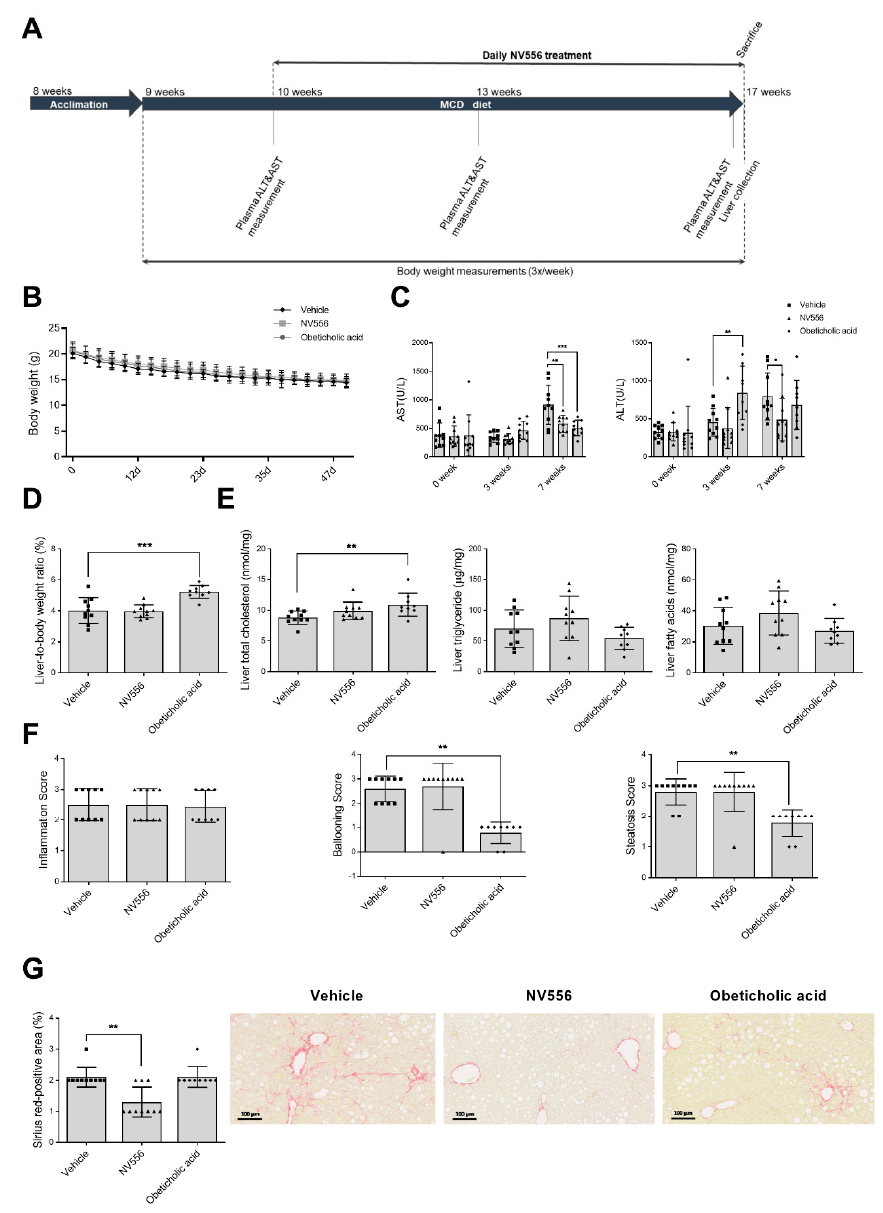
Figure 1. Effect of NV556 treatment in methionine-choline-deficient (MCD)-diet-fed mice. ( A ) Experimental timeline and parameters measured: ( B ) body weight, ( C ) AST, and ALT, ( D ) liver/body weight ratio (%), ( E ) liver total cholesterol, liver triglycerides, and liver fatty acids; and ( F ) NAFLD scoring–inflammation, ballooning, steatosis score, and ( G ) fibrosis stained by Sirius red. Representative photomicrographs of Sirius red staining (Scale bars indicate 100 µ m). Data are represented as mean ± SD and statistically analyzed by one-way ANOVA, followed by Dunnett’s multiple comparison test for C , D , and E . F and G were statistically analyzed by Kruskal Wallis, followed by Dunn’s multiple comparison test, * p < 0.05, ** p < 0.01, *** p < 0.001, n = 10 mice per